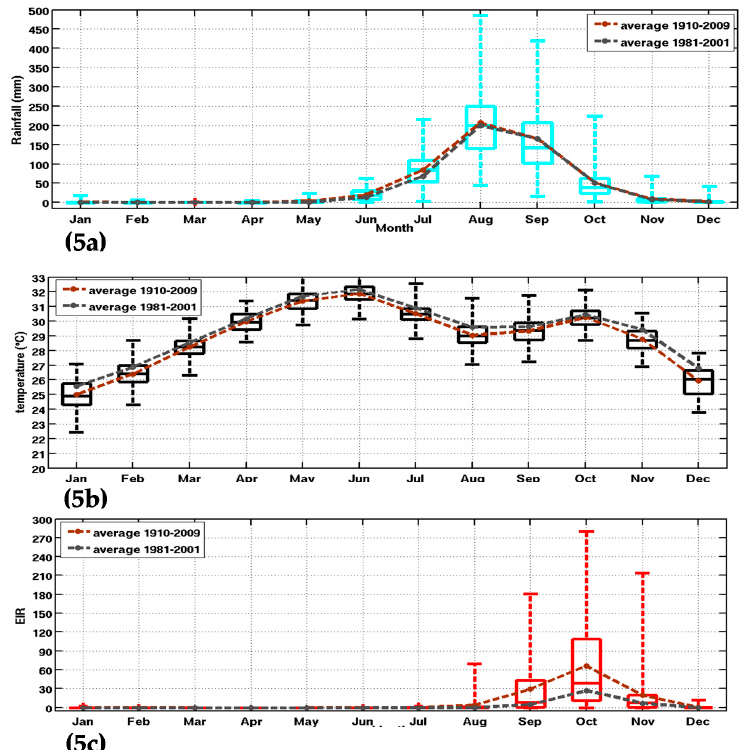
Figure 5. Box ‐ and ‐ whisker plot of climate parameters and the simulated malaria parameter: ( a ) rainfall (mm); ( b ) temperature (°C); and ( c ) simulated EIR (infectious bites per person per month) in Senegal. The whiskers and max/min outliers are shown for inputs and outputs of the Liverpool Malaria Model (LMM) for the 20th CR dataset (1910–2010). The boxes mark the median, the 25 th, and the 75 th percentile, while the whiskers give the minimum and maximum values. The brown and grey curves represent, respectively, the superimposed mean annual cycles on the Box ‐ and ‐ whisker for 1910–2009 and the common climatological period to the other reanalysis dataset (1981–2001).